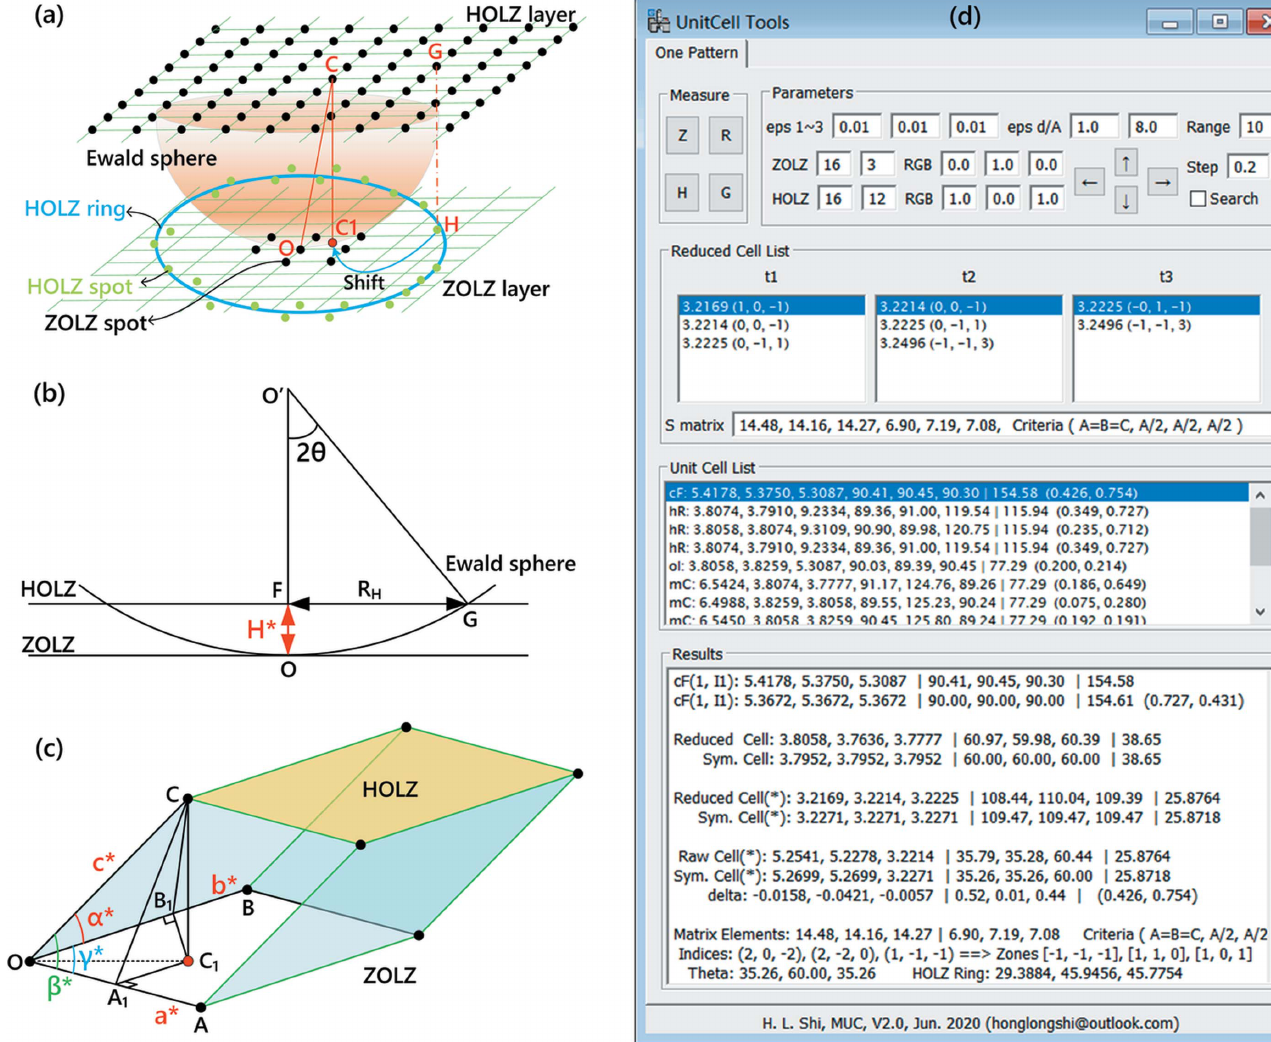
Figure 1 Determination of unit-cell parameters from an electron diffraction pattern containing high-order Laue zone (HOLZ) reflections. ( a ) Schematic of reciprocal-lattice layers projected to form an electron diffraction pattern containing HOLZ reflections. ( b ) Calculation of the reciprocal-lattice layer spacing H * by measuring the radius of the HOLZ ring R H . ( c ) Geometrical construction of a 3D primitive cell in reciprocal space. ( d ) Graphical user interface of the package UnitCell Tools